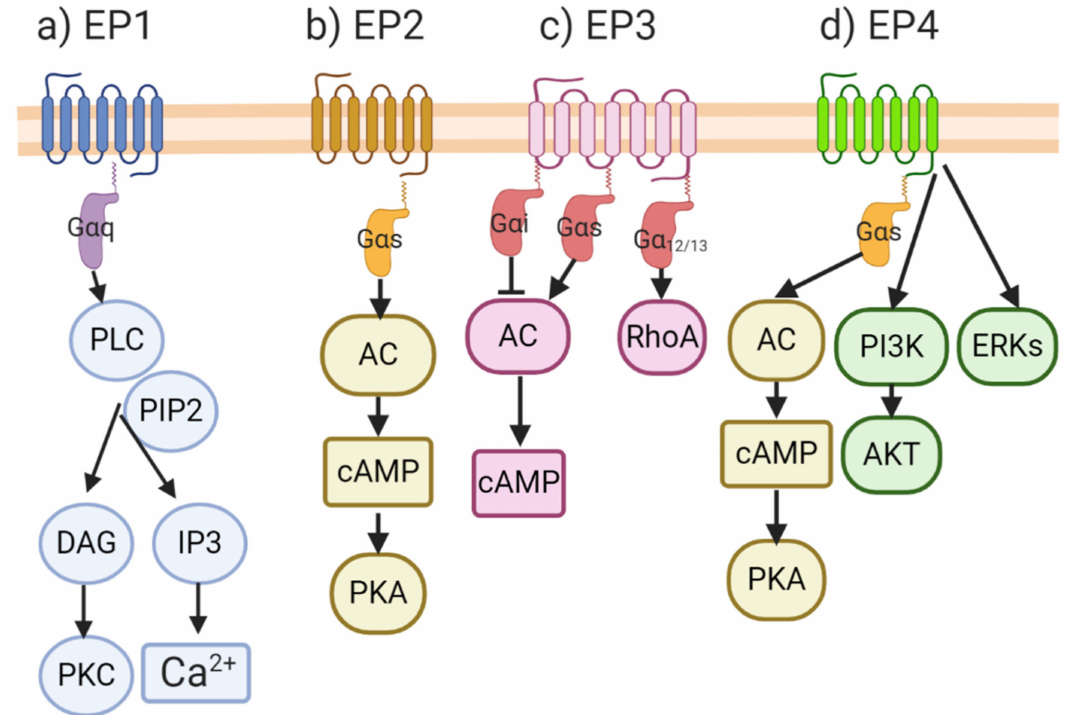
Figure 5. Signaling through the EP family of receptors. EP receptors belong to the family of GPCRs: ( a ) signaling through the EP1 receptor results in the activation of PKC and a higher concentration of intracellular Ca 2+ ; ( b ) EP2 receptor signaling induces the production of cAMP and the activation of PKA; ( c ) EP3 is associated with different G proteins: depending on which G α is associated with EP3, it can increase or decrease cAMP; and activate the Rho family ATPases; ( d ) EP4 and EP2 share the same pathway of PKA activation when PGE2 binds to them. Unlike EP2, signaling through EP4 also stimulates non-canonical activation of the PI3K/AKT and ERK pathways. Figure adapted from Lala et al., (2018)